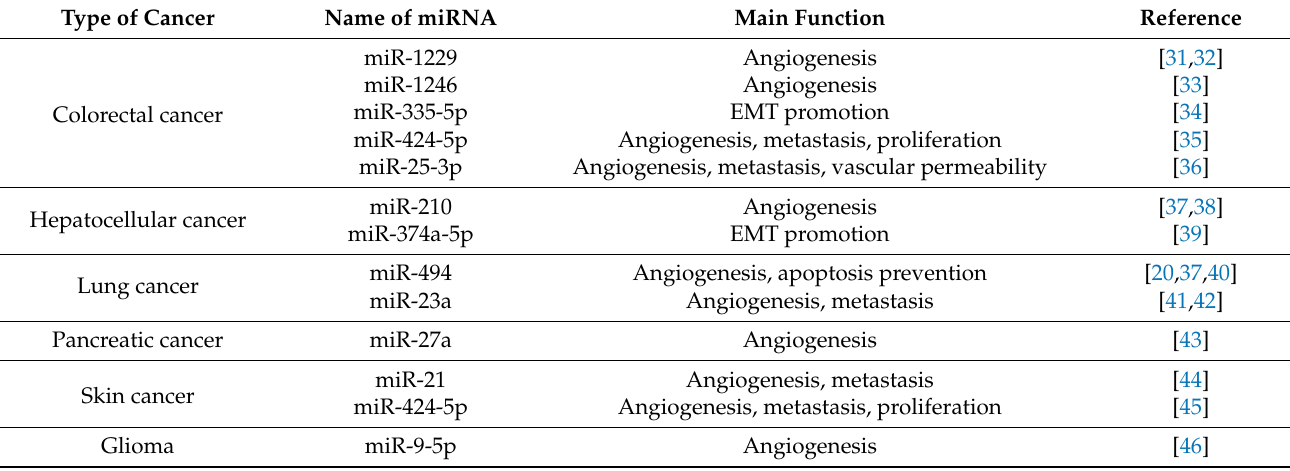
Table 1. Common cancer promoting exosomal miRNA and their